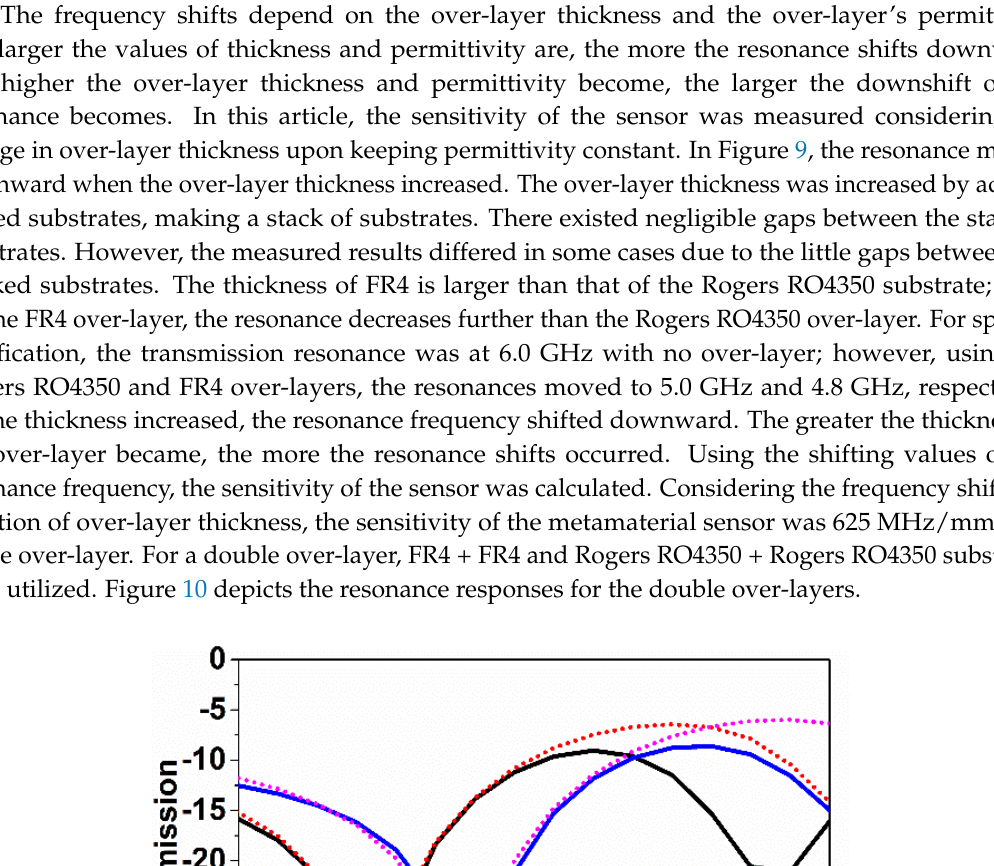
Figure 11. Transmission variances with FR4 and Rogers RO4350 multiple over-layers.